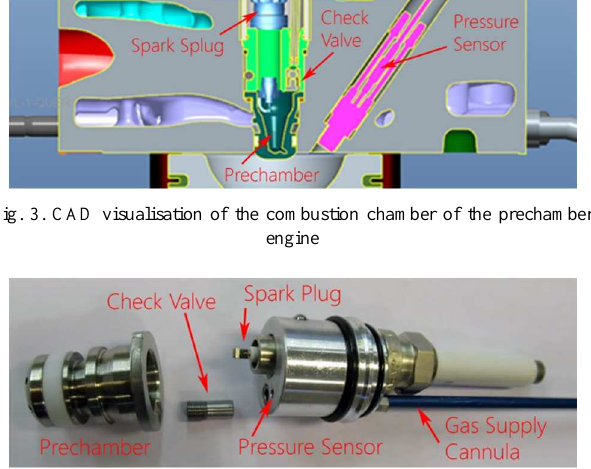
Fig. 4. Prechamber assembly, including the prechamber pressure sensor and the gas supply